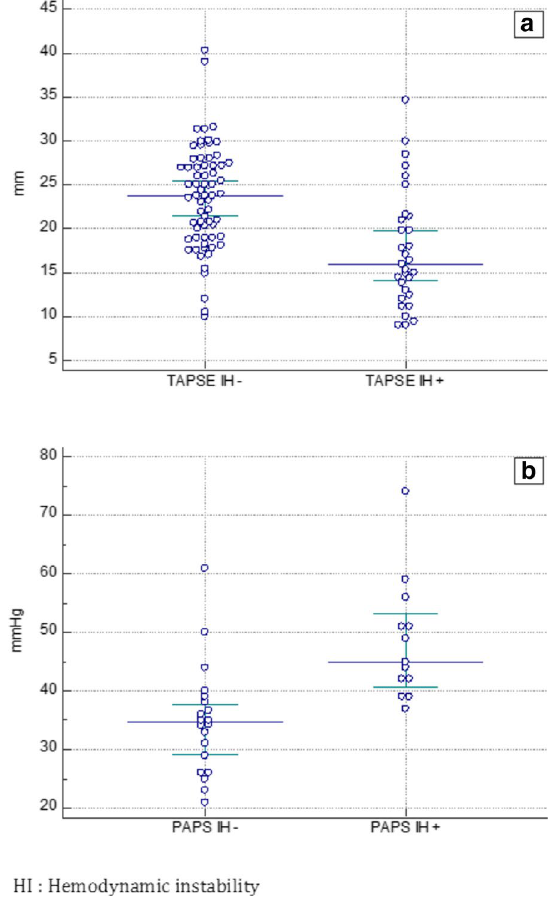
Fig. 1 Comparison of predialysis TAPSE ( a ) and PAPS ( b ) values according to the occurrence or not of hemodynamic instability during the dialysis